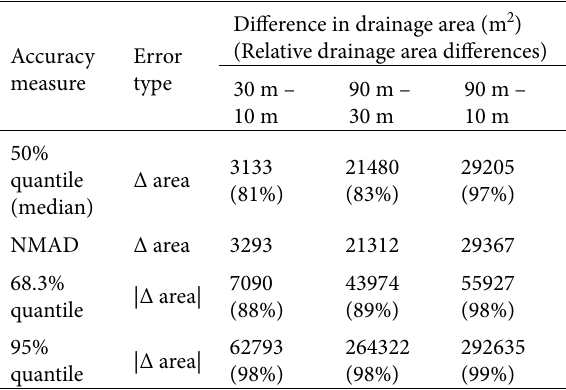
Table 5. Measures of accuracy showing that larger drainage ar- eas are obtained with lower resolution of the DEM, Sample size is equal to 2310